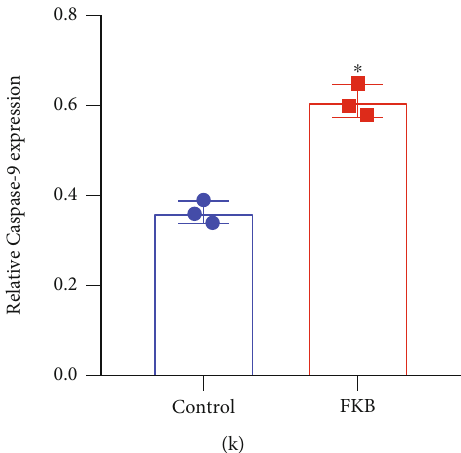
Figure 1: FKB suppresses growth and induces apoptosis of gastric cancer cells. (a) Cell growth curve for SGC-7901 cells after treatment with FKB. (b, c) Apoptosis of SGC-7901 cells was investigated following FKB treatment utilizing Annexin V-FITC/PI test. (d) Representative images of western blots. (e) Bax, (f) Bcl-2, (g) Bax/Bcl-2, (h) caspase-3, (i) caspase-7, (j) caspase-8, and (k) caspase-9 expression was quanti fi ed in SGC-7901 cells of the two groups. ∗ p < 0 : 05 ; ∗∗ p < 0 : 01 ; ∗∗∗ p < 0 : 001 ; ∗∗∗∗ p < 0 : 0001